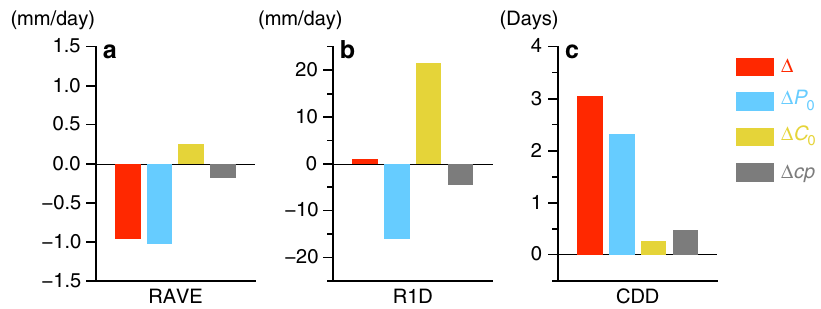
Fig. 3 Changes in the precipitation indices for evaluation. Differences from the present climate in domain-averaged 25-year means of the a daily mean precipitation (RAVE), b maximum one-day precipitation (R1D) and c maximum number of consecutive dry days (CDD), respectively. Δ is the total change estimated by the DDSs (Future-DDS − Present-DDS). Δ P 0 and Δ C 0 indicate the contributions of the perturbation and climatology, respectively. Δ cp is